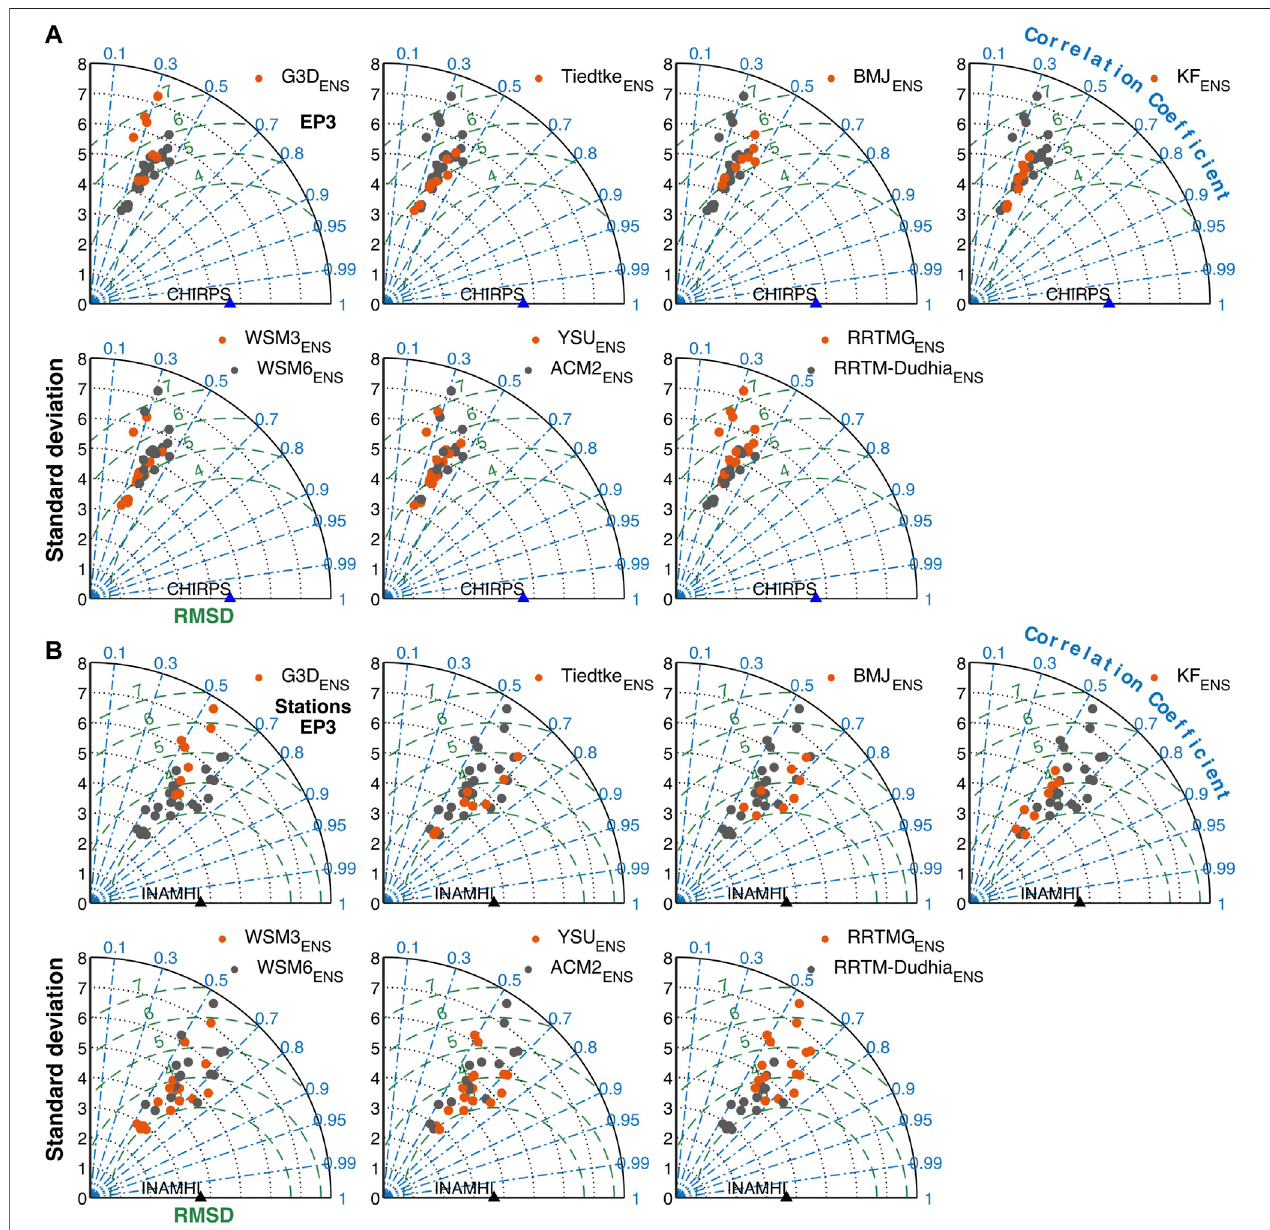
FIGURE 9 | As Figure 8 , but for EP3, with (A) CHIRPS reference data and (B) INAMHI station data. A direct comparison of CHIRPS and INAMHI station data on a daily scale in one plot as in Figure 8 for MSWEP and ERA5-Land is not possible due to different accumulation times of 00 UTC – 00 UTC (CHIRPS) and 12 UTC-12 UTC (07 – 07 am local time, INAMHI stations), respectively. For the comparison with INAMHI stations, the mean of the 106 selected stations or respective modeled nearest grid-cell data was used.